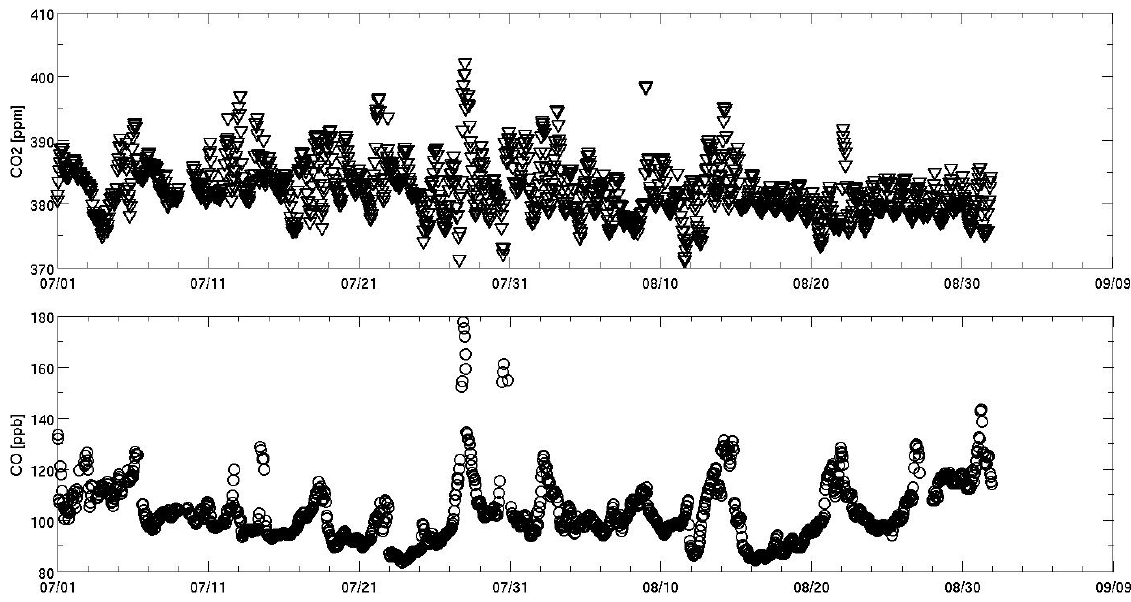
and CO measured in situ at Pallas 2